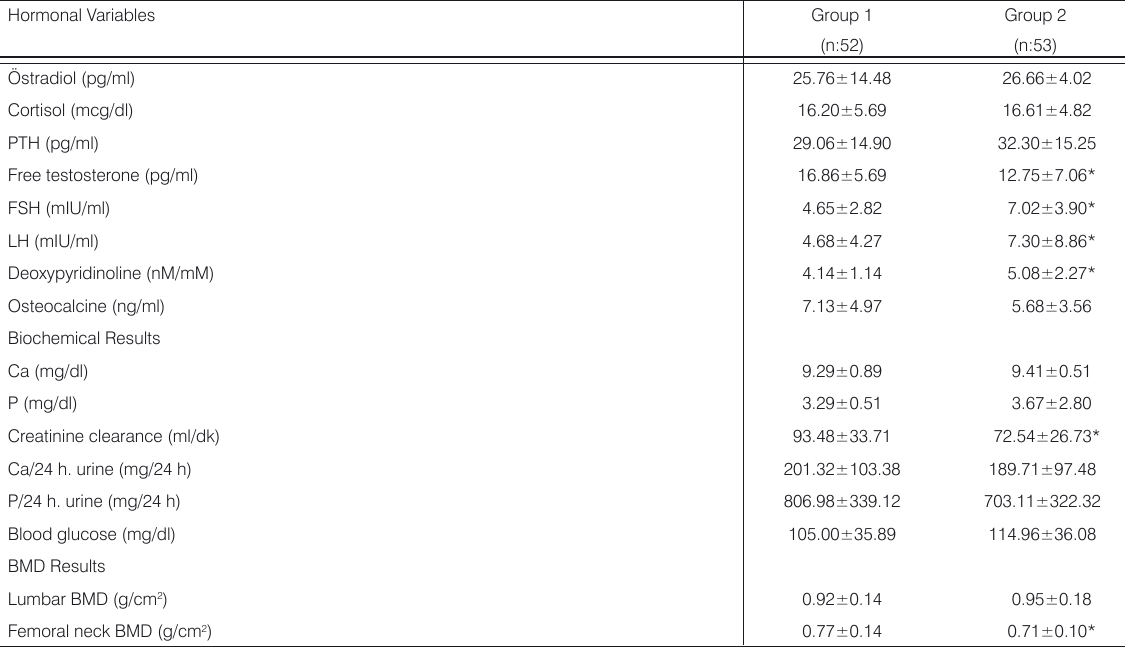
Table 2. Hormonal, biochemical, and BMD results of Group 1 (<60 years) and Group 2 ( ≥ 60 years).